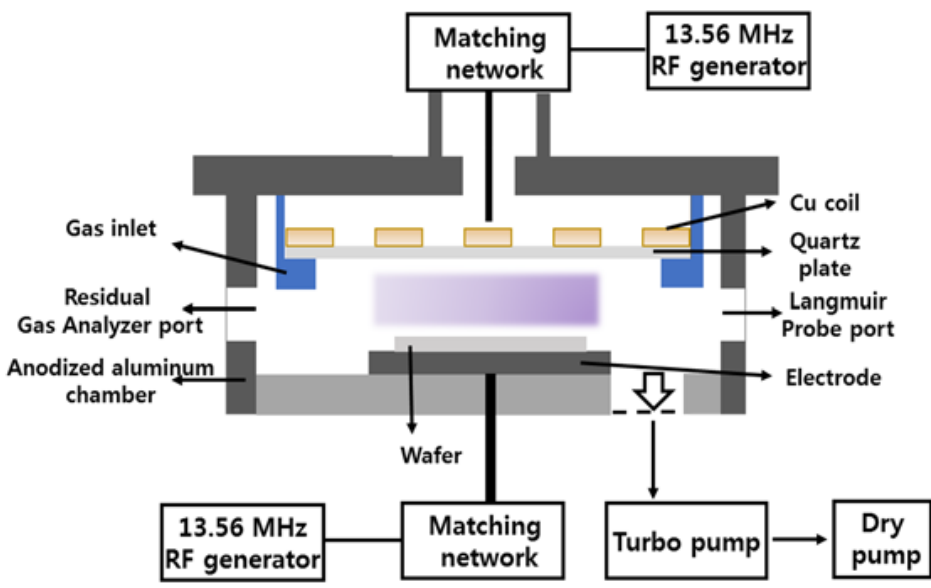
Figure 1. Schematic diagram of the reactor chamber with surroundings.